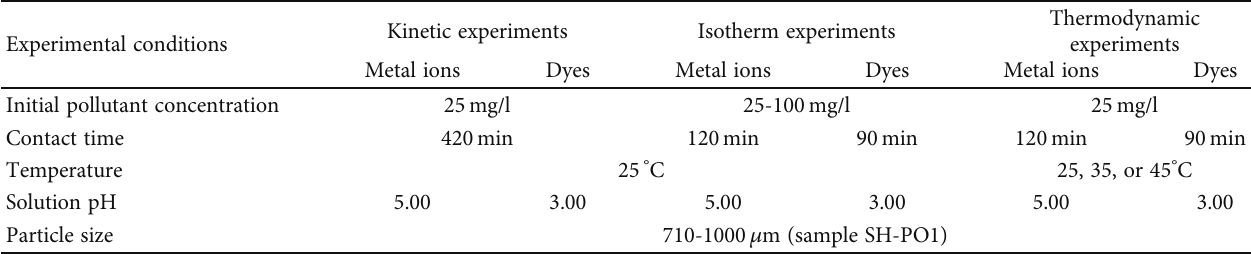
Table 1: The kinetic, isotherm, and thermodynamic experiments ’ conditions. Experimental